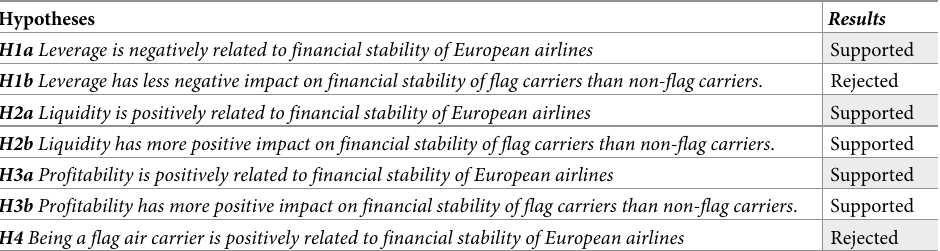
Table 5. Supported and rejected